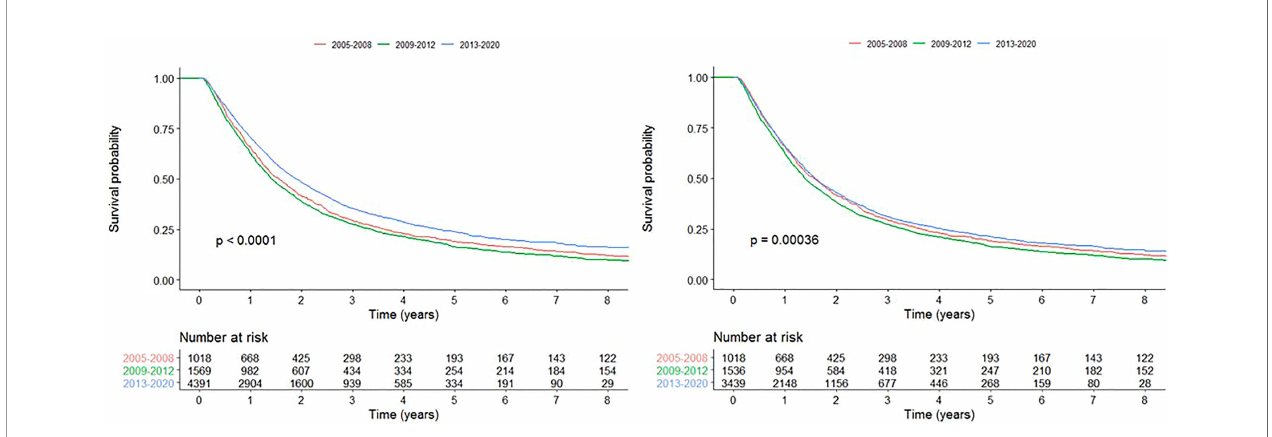
FIGURE 6 | Kaplan-Meier survival curves for each time period for all patients treated with curative-intent radiotherapy (left) and curative-intent without SABR (right).